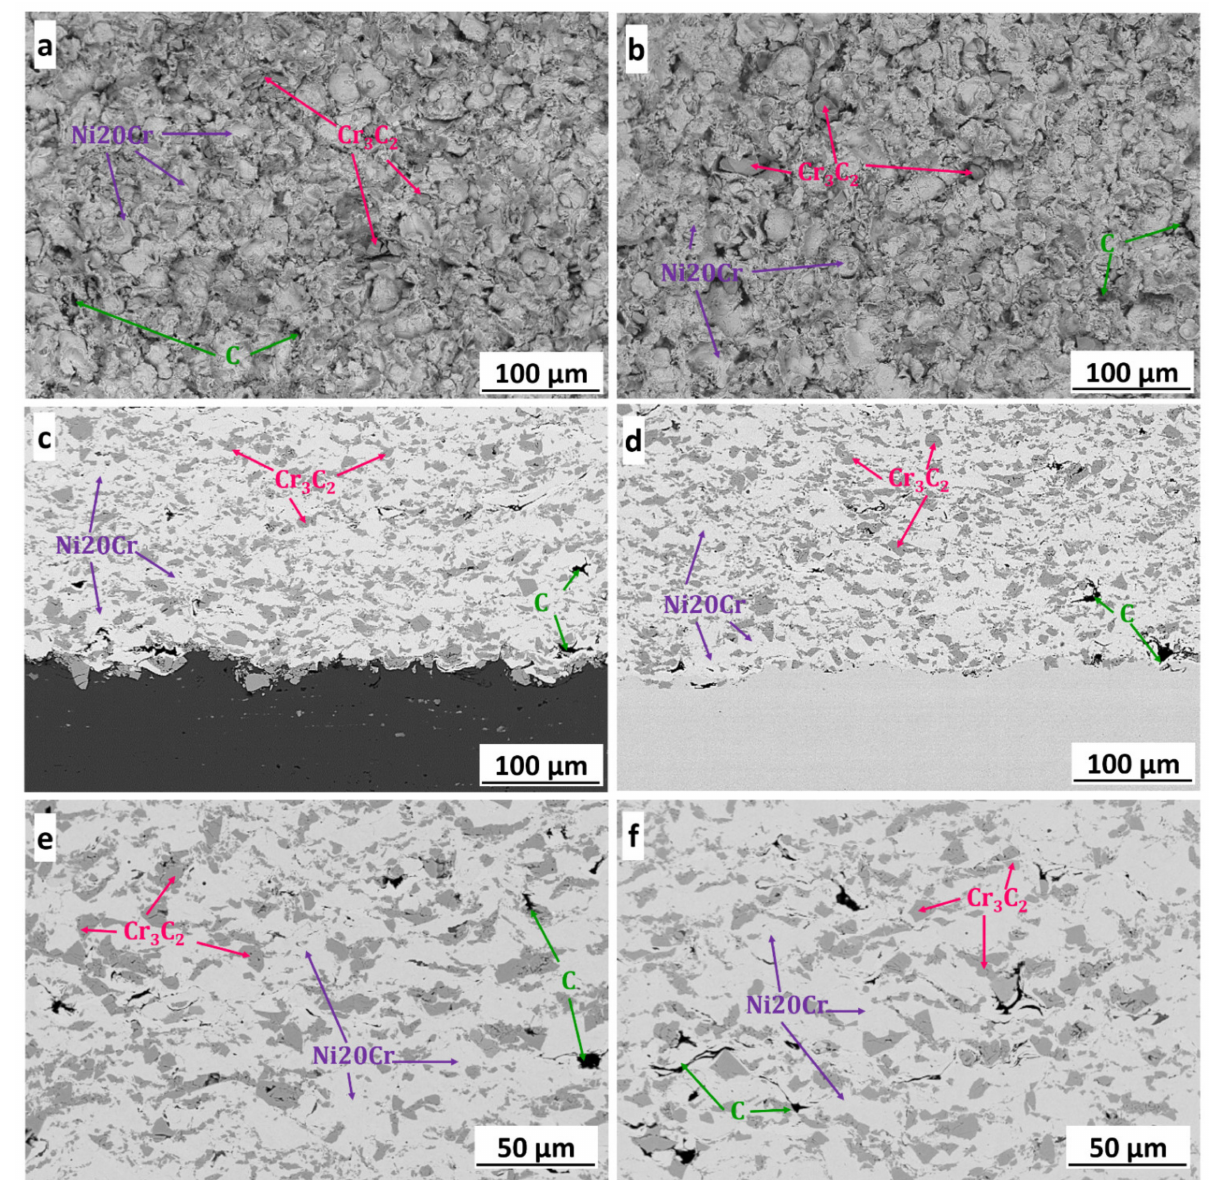
Figure 4. SEM surface morphologies and cross-sections of the (Cr 3 C 2 -25(Ni20Cr))-(Ni25C) coatings